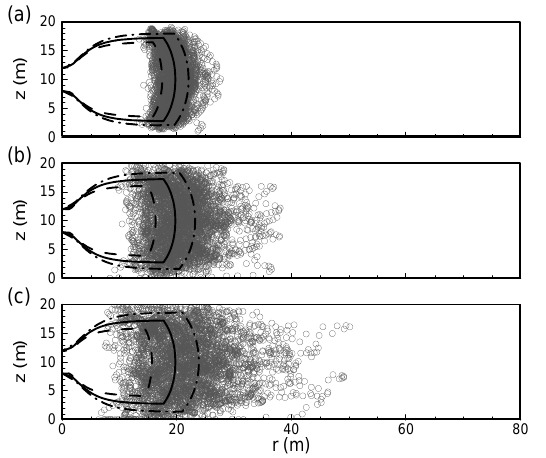
Fig. 11. Stochastic remediation zones obtained by using first-order NSM at t = 80day (flooded contours: mean head distribution; solid lines: mean remediation zone; dashed lines: mean- σ R , and dash-dotted line: mean+ σ R ) for fixed r-direction correlation length of 5m and lnK variance of 0.5 in a layered aquifer: (a) the screen opened in the central portion of the well (8 to 12m), (b) the screen opened in the lower portion of the well (2 to 6m), and (c) the screen opened in the upper portion of the well (14 to 18m).